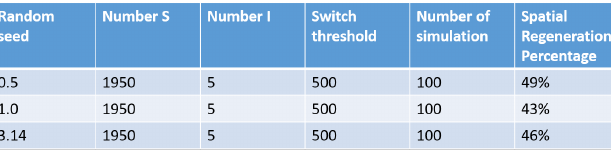
Figure 11. Average result by simulate 100 times the spatial regeneration